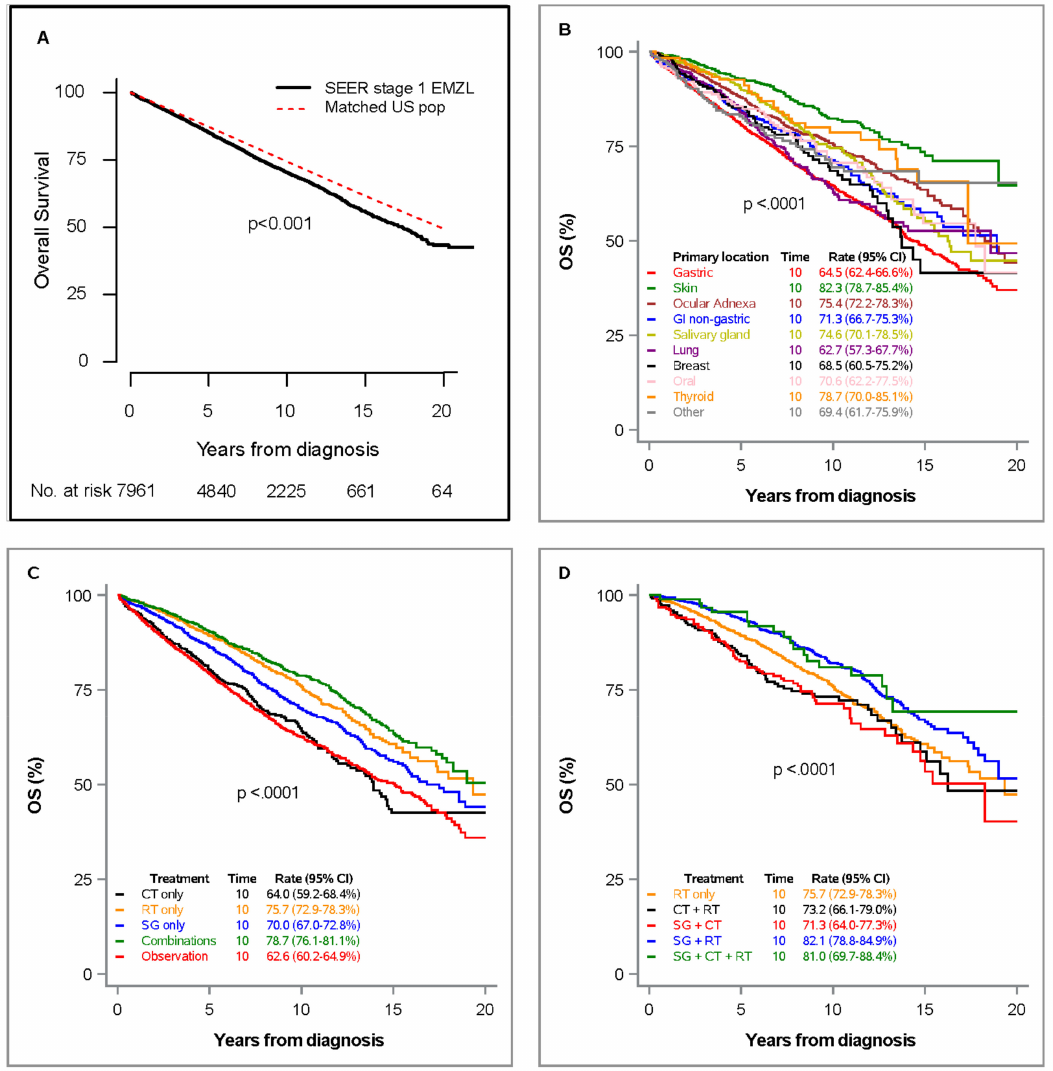
Figure 2. Overall survival in SEER stage I EMZL cohort vs. age-, sex-, and calendar-matched U.S. population cohort ( A ); overall survival in SEER stage I EMZL cohort by primary location ( B ), by treatment modality ( C ), and by combined treatment modality and RT only ( D ). Tick marks for censored observations not shown given the large number of